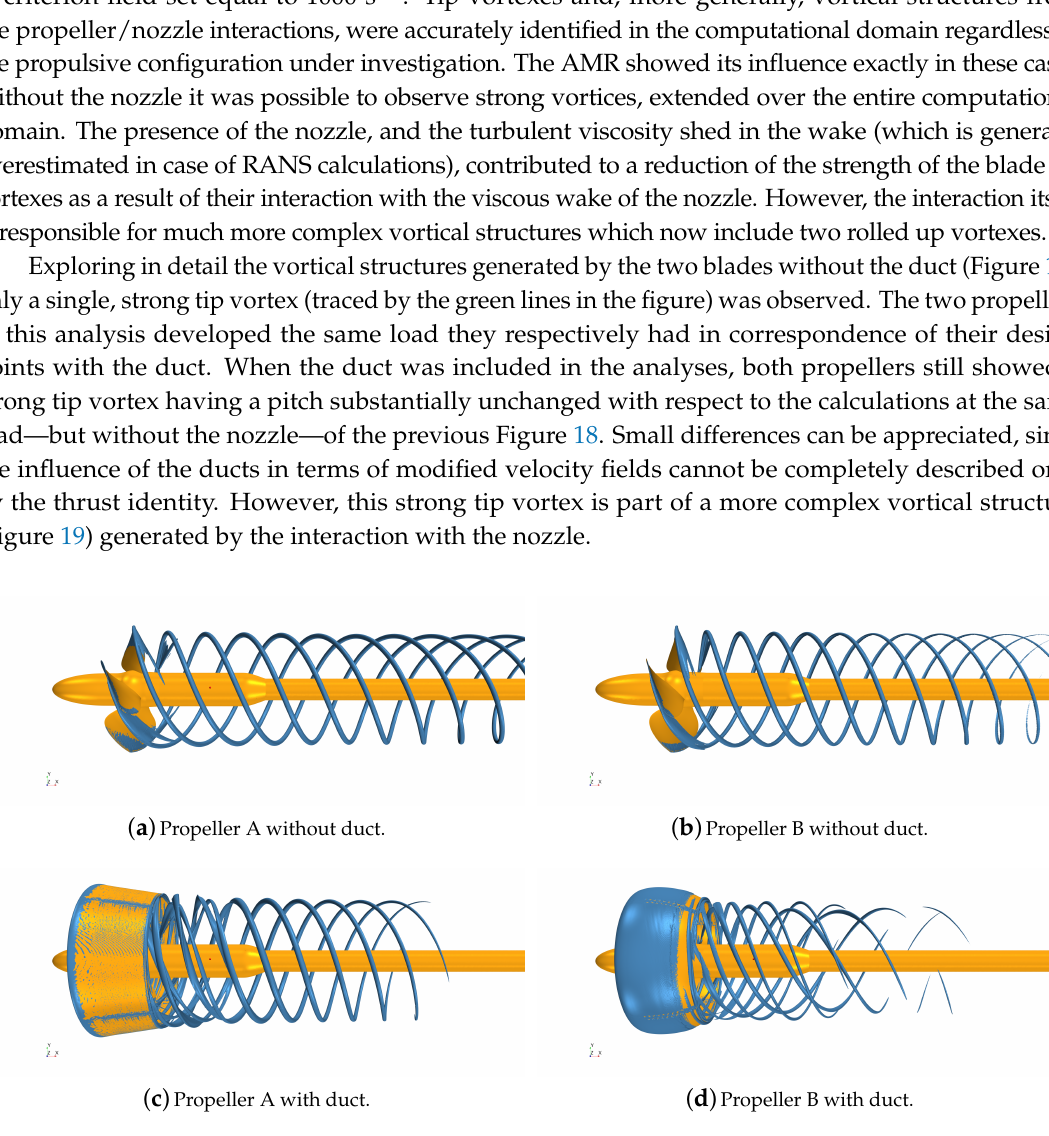
Figure 17. 3-D view of computed vortexes tracked by the Q